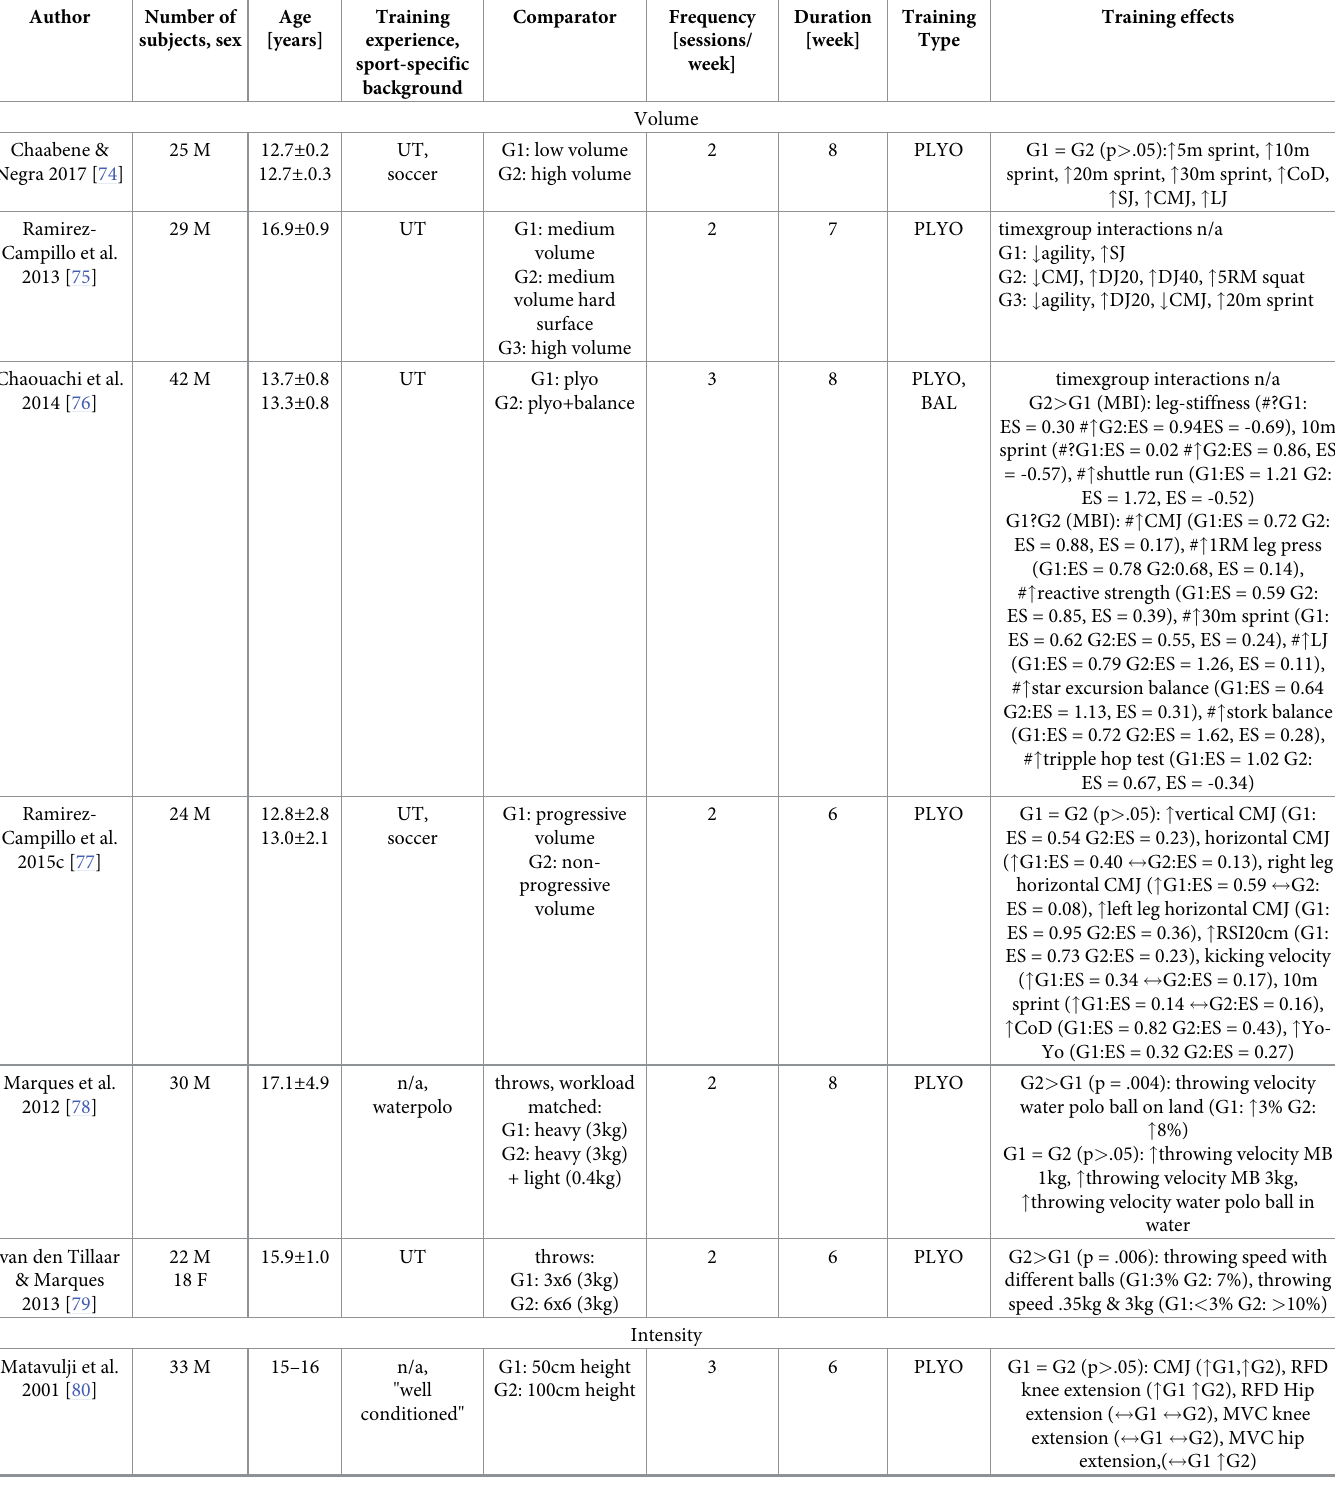
Table 10. Influence of the moderating variables ‘training intensity and volume’, ‘surface stability’ and ‘rest’ on plyometric training induced improvements in com- ponents of physical